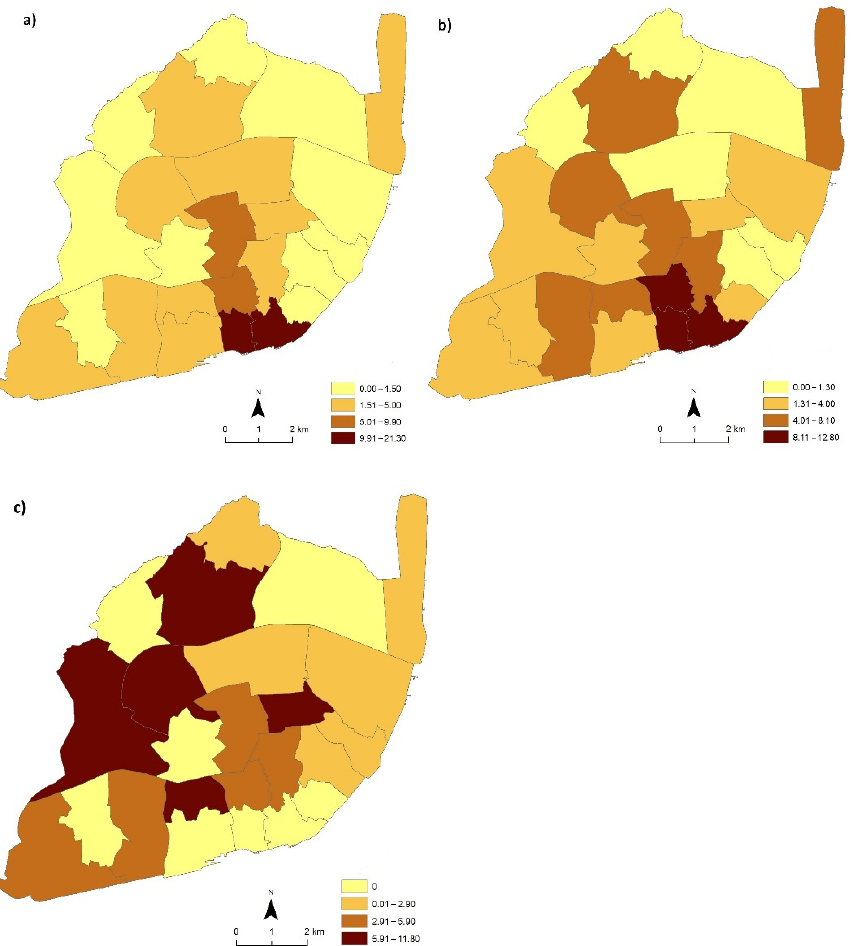
Figure 4. Spatial distribution of the sample according to the type of registration (%). ( a ) Registration made by the firm; ( b ) Registration made by the user; ( c ) Unaware of registration.